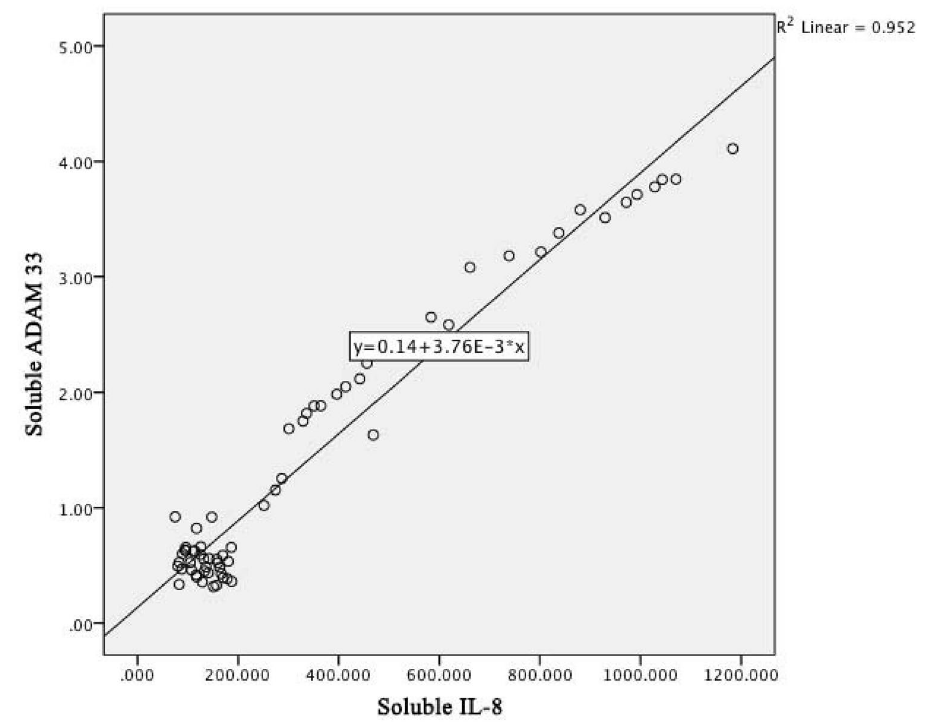
Figure 4. Linear regression graph between IL-8 and ADAM33 level in COPD patients.